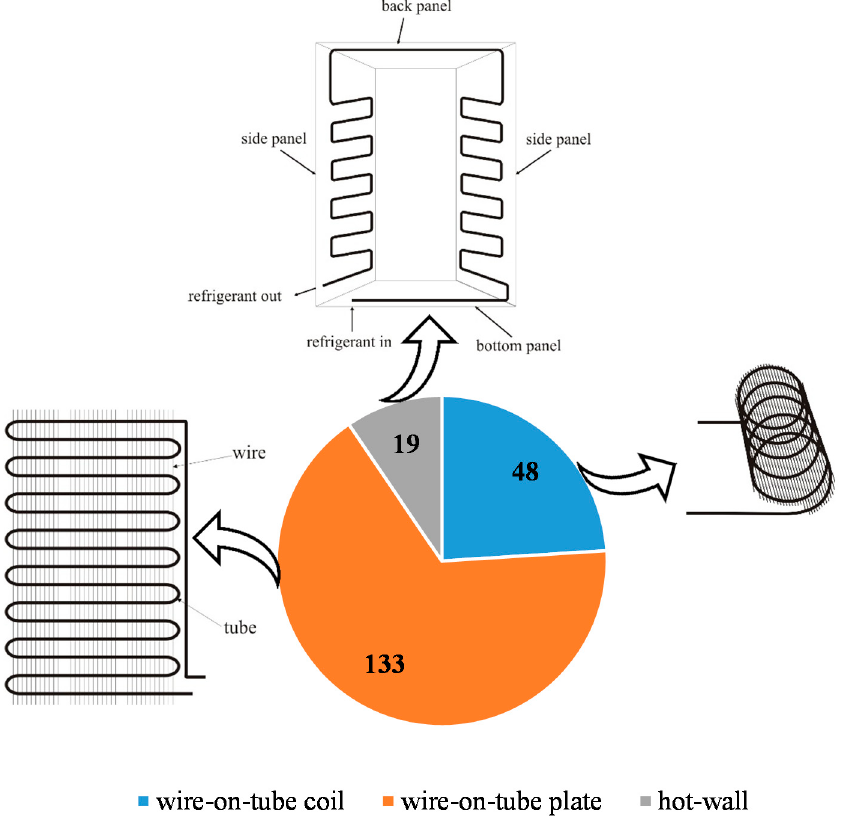
Figure 3. Types of condensers in the studied refrigerators.